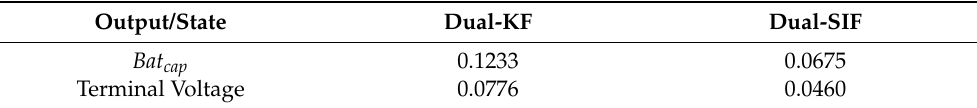
Table 5. RMSE Results for both